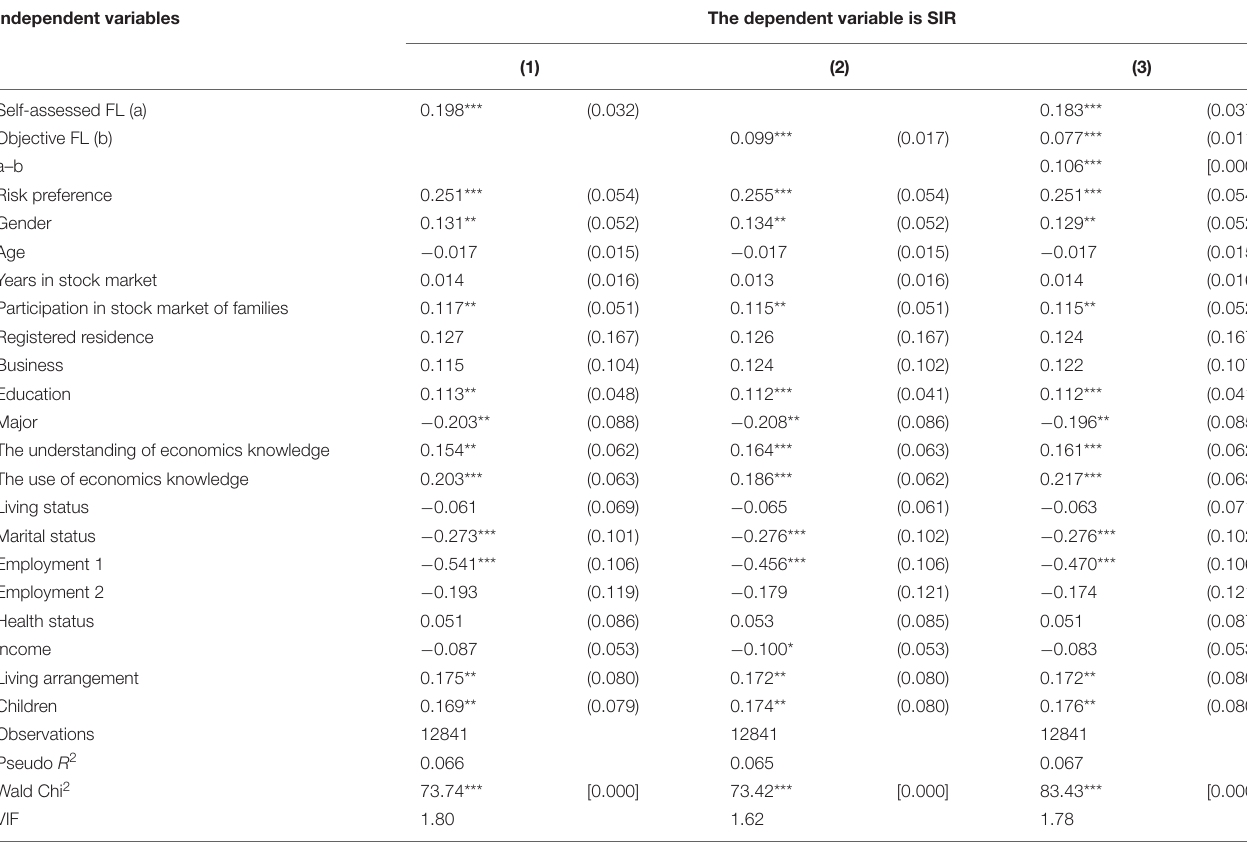
TABLE 7 | The Ordered Probit regression results of the relationship between self-assessed and objective FL and SIR. Independent variables The dependent variable is